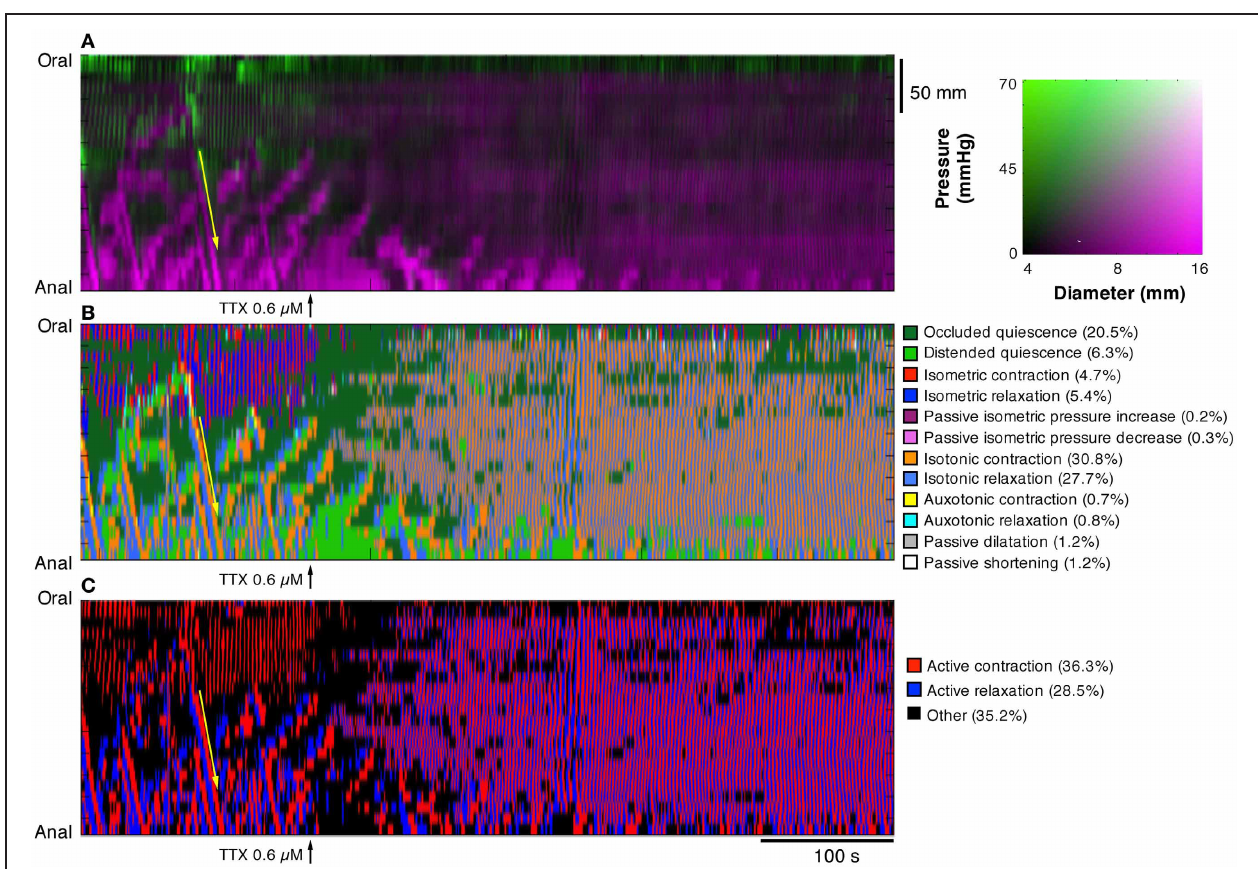
FIGURE 10 | After the addition of 0.6 µ M tetrodotoxin (TTX) the map of steady state of the orbits (B, C), constructed from the DPMap (A), shows that the peristaltic propagating contractions (yellow arrow) are blocked,